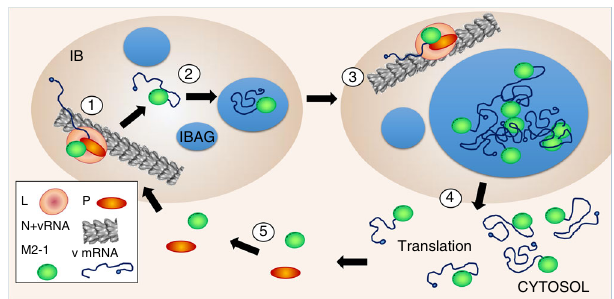
Fig 9 Model of viral mRNA traf fi cking. (1) Viral mRNA synthesis occurs in IBs in area containing genomic viral RNA and N, L, P and M2-1 (designated as peripheral area). M2-1 binds to nascent mRNA poly(A) tail. (2) These RNA – protein complex together with cellular proteins mediate condensation of IBAGs recruiting the newly synthetized mRNA-M2-1 complexes. (3) IBAGs grow and fuse together. (4) When reaching critical size, IBAGs disassembly releases the mRNAs most probably still bound to M2-1 into the cytoplasm. (5) Newly synthetized M2-1 (and possibly M2-1 released from viral mRNA) bind with P in the cytoplasm and is imported in